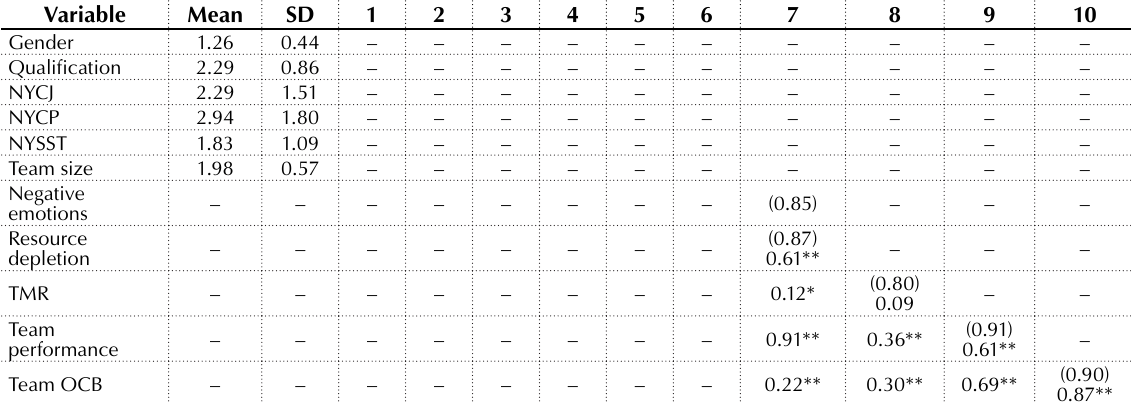
Source: Primary data.